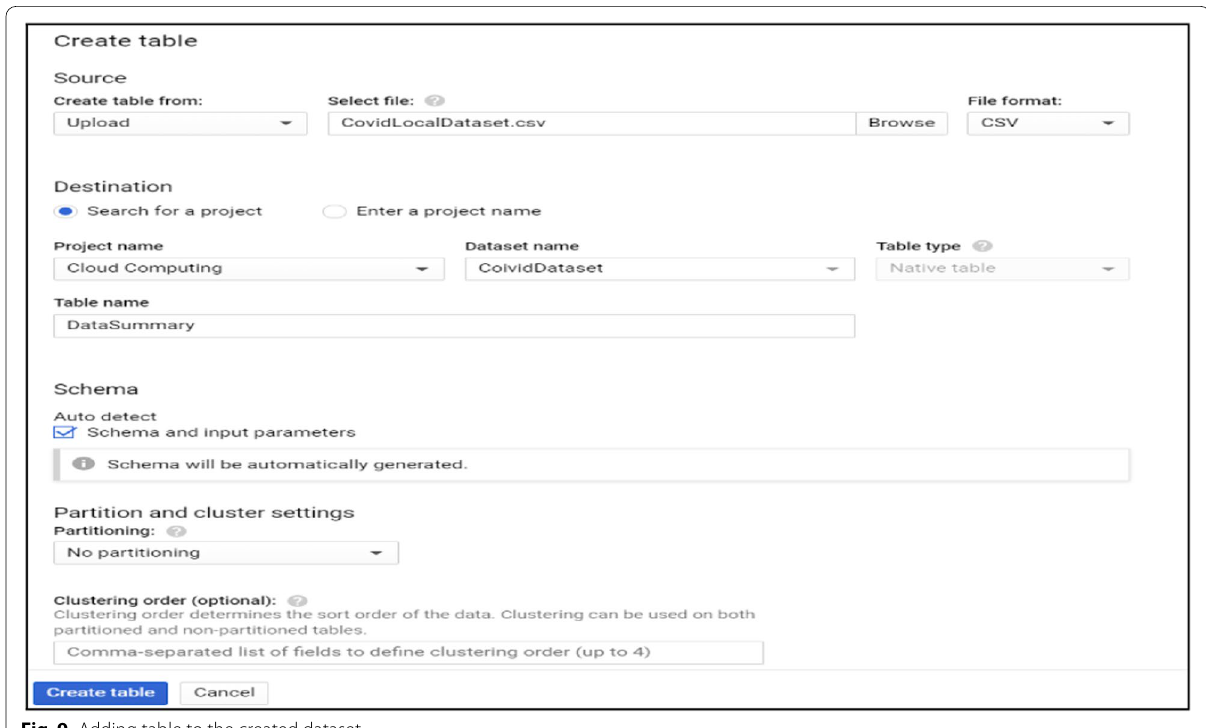
Fig. 9 Adding table to the created dataset